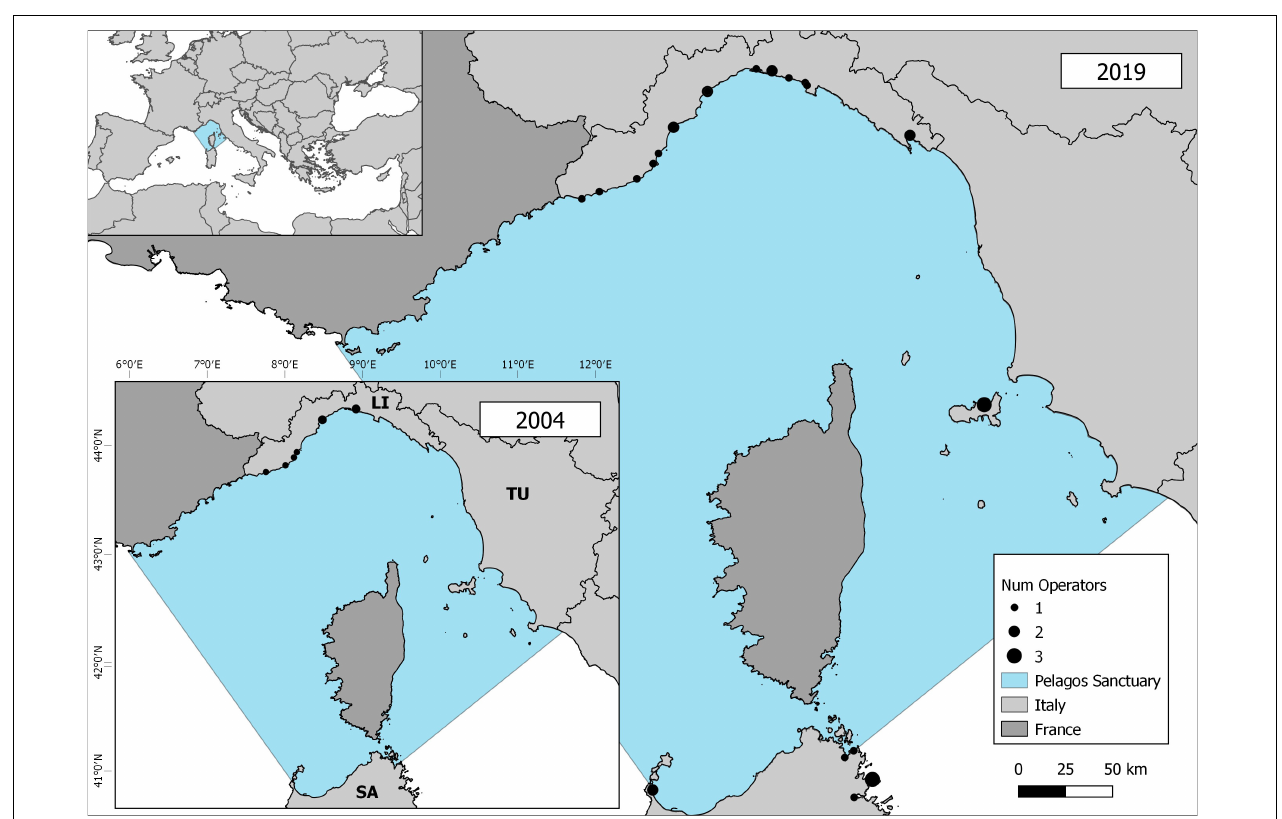
FIGURE 1 | Map of departing harbors of COM whale watching operating in the Pelagos Sanctuary, in 2004 and in 2019. Italian regions overlooking the Pelagos Sanctuary are Liguria (LI), Tuscany (TU), and Sardinia